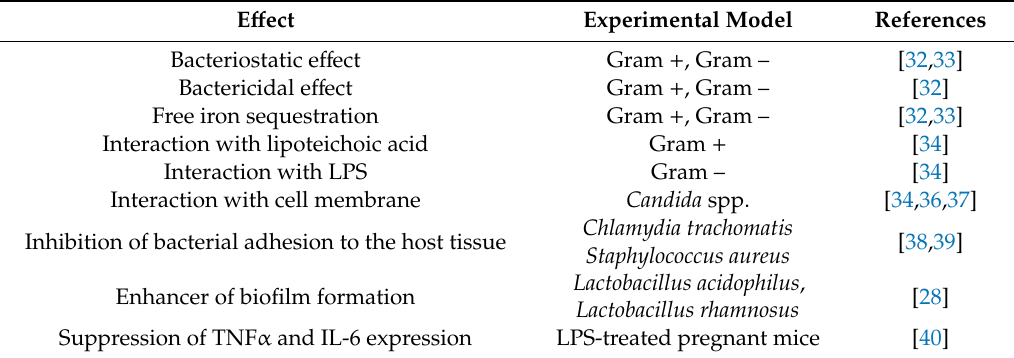
Table 1. E ff ects of Lactoferrin: Preclinical